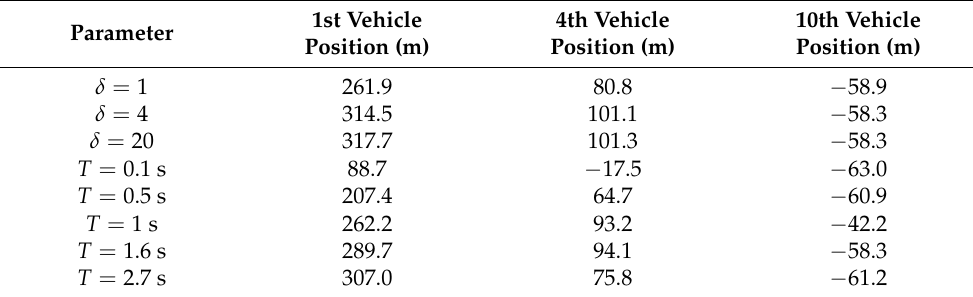
Table 6. Position of the 1st, 4th, and 10th vehicles at 30 s with the ID and proposed